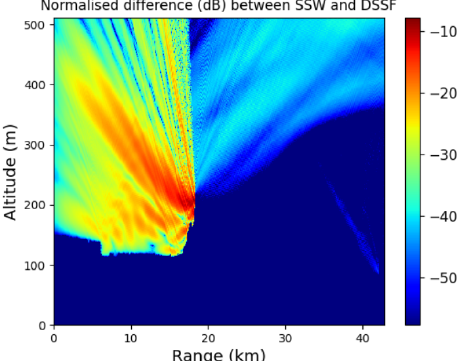
Figure 11. Normalized difference between the one-way SSF and two-way SSW schemes along the